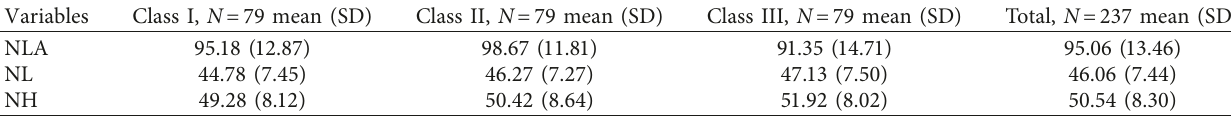
Table 2: Mean values of nose variables among different skeletal malocclusion groups.